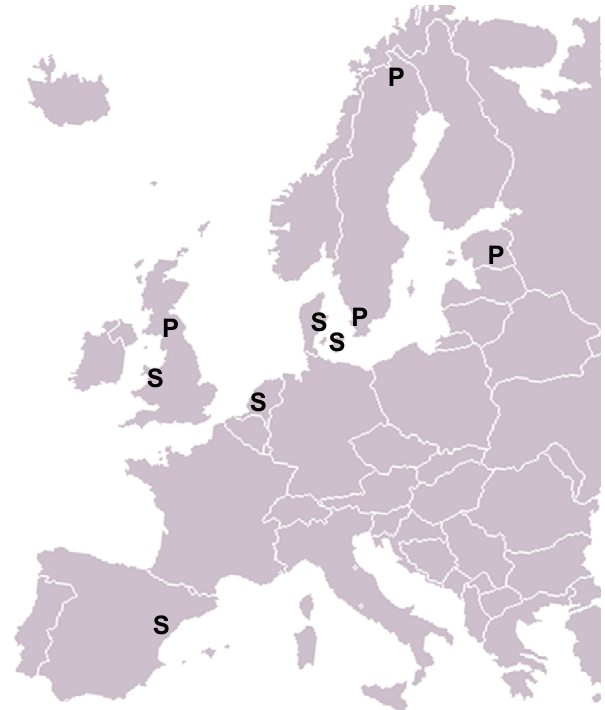
Fig. 1. Location of the nine experimental sites across Europe. Ab- breviations are P for “peatland” and S for